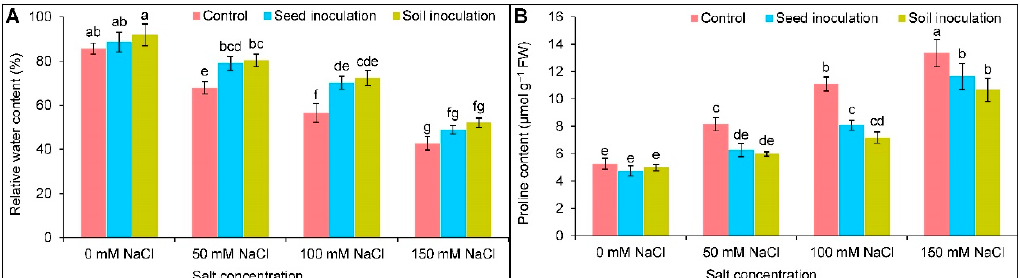
Figure 3. Effect of Bacillus subtilis in response to different concentrations of salt stress, on the relative water content ( A ) and proline content ( B ) of soybean ( Glycine max cv. BARI Soybean-5). Values in a column are mean ± SD. Different letters on each bar indicate significant differences among the treatment after applying a Tukey’s HSD test at p ≤